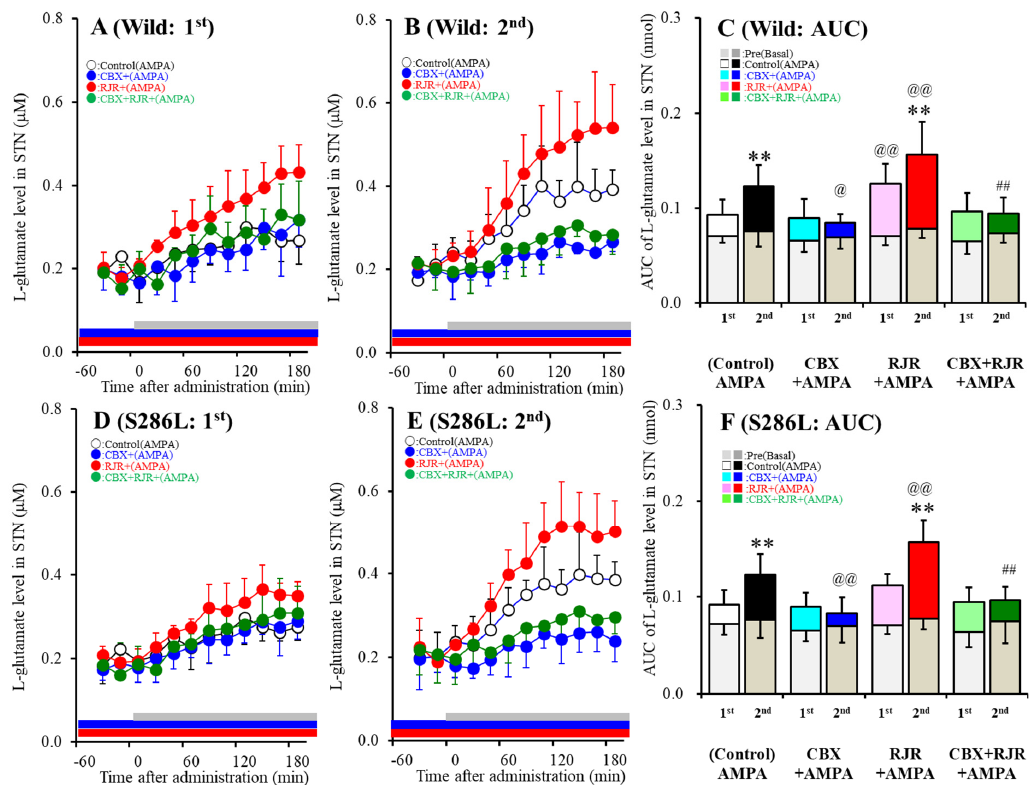
Figure 3. Effects of the local administration of 100 µ M RJR2403 (selective α 4 β 2-nAChR agonist) and 100 µ M CBX (hemichannel inhibitor) into the OFC on 100 µ M AMPA-evoked (perfusion with 100 µ M AMPA into the OFC) L-glutamate release in the STN, before ( A , D ) and after ( B , E ) hemichannel activation (FCHK-MRS (Ca 2 + -free with 100 mM K + ) perfusion) of the wild-type ( A , B ) and S286L-TG